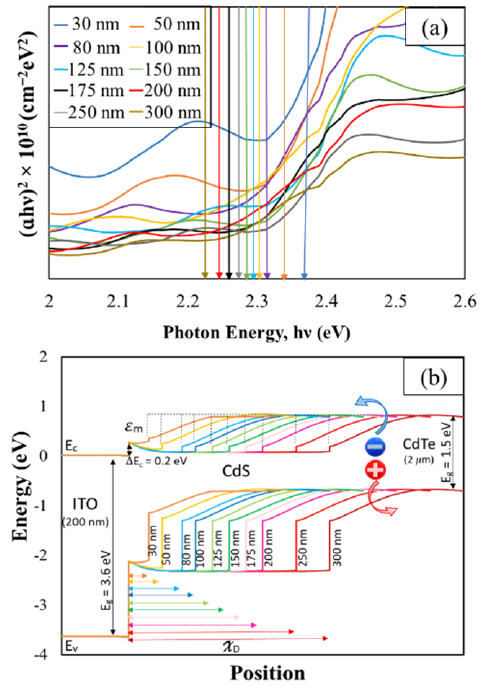
Figure 9. ( a ) Band gap and ( b ) Energy band diagrams of the possible device configurations for different CdS thickness.